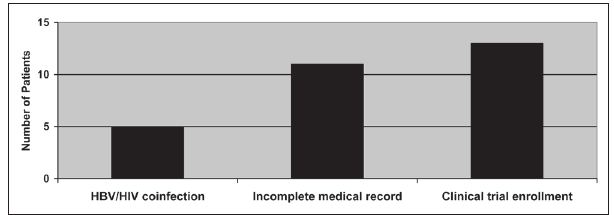
Figure 1) Patients excluded from study participation. HBV Hepatitis B